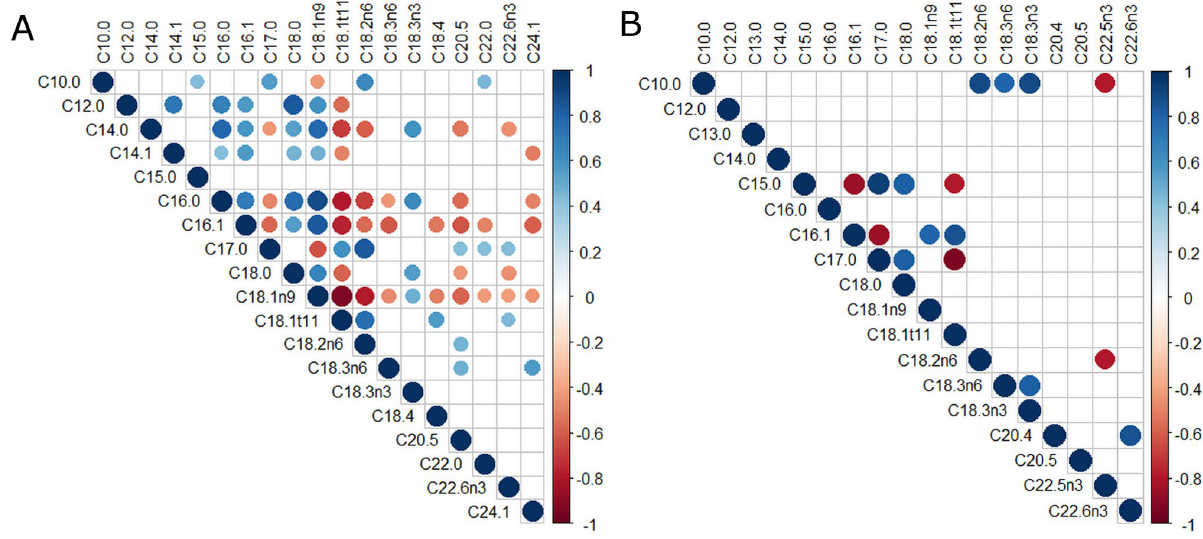
Fig 3. Correlations of FAs percentage in blood serum. A. SCC grade 1+2. B. SCC grade 3. Red or blue dots on the correlogram, depending on the direction of the correlation, the dot size in the correlation matrix is proportional to the strength of the